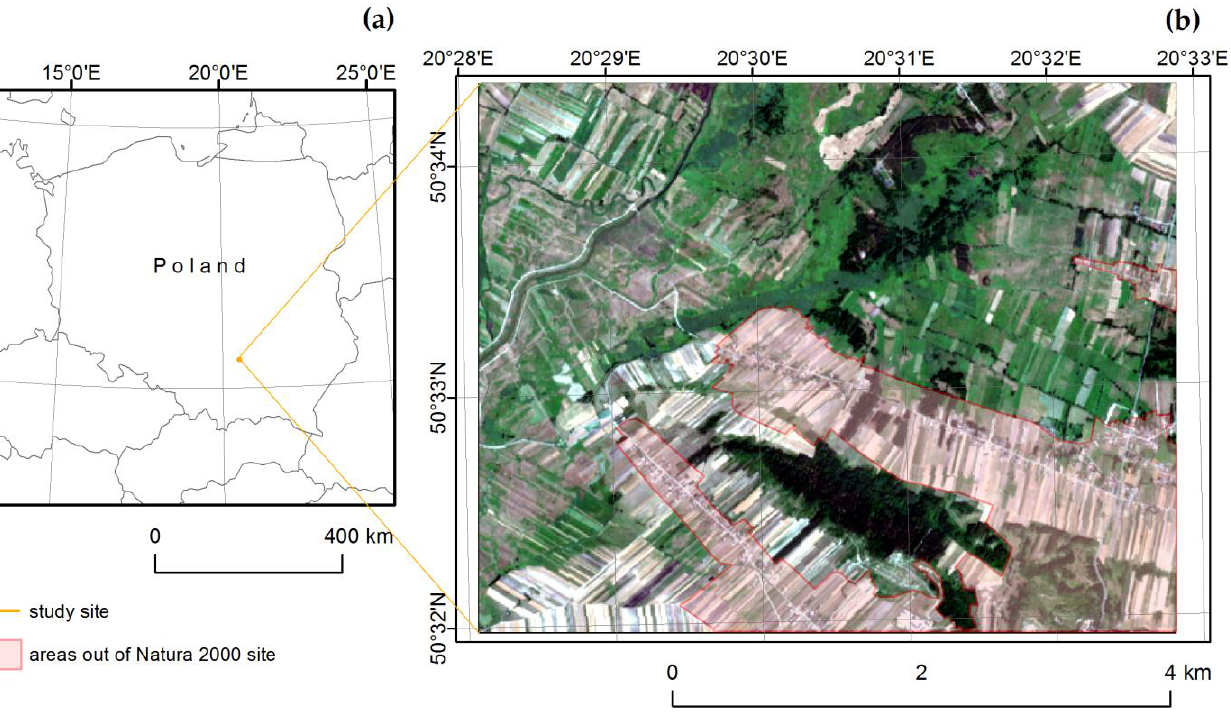
Figure 1. Study site: ( a ) Location in Poland and neighboring borders; basemap: © EuroGeograph- ics for administrative boundaries; ( b ) Sentinel-2 data of Ostoja Nidzia´nska Natura 2000 site from 16 August 2017 (RGB 432 composite); vector layer: